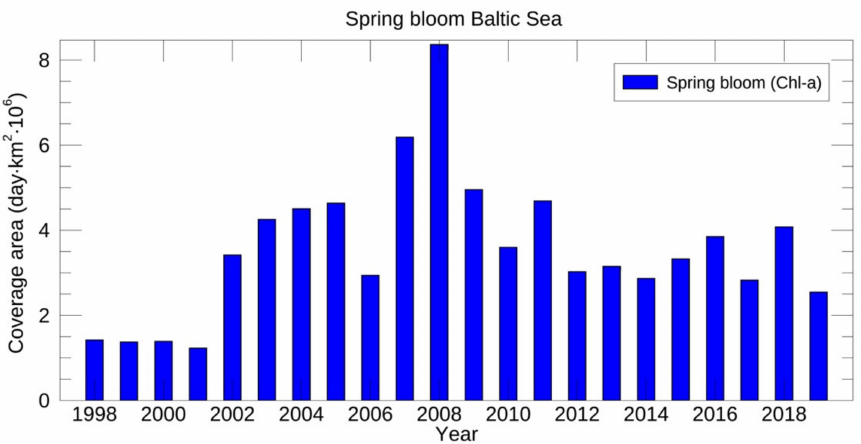
Figure 7. Spring bloom coverage time series for the whole Baltic Sea.